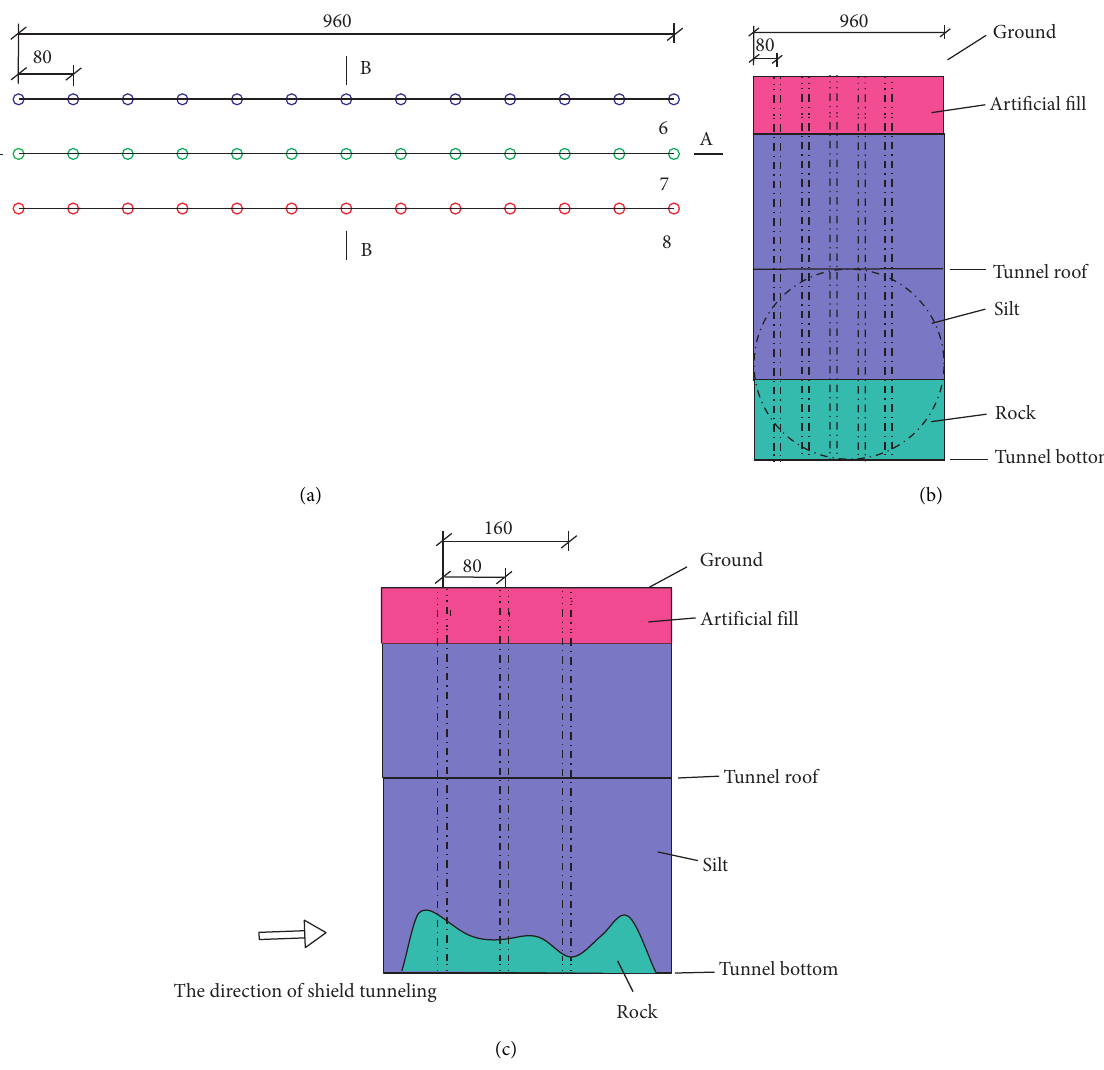
Figure 4: Sketch map of blastholes (cm). (a) Planar graph, (b) cross section of A-A, and (c) cross section of B-B.